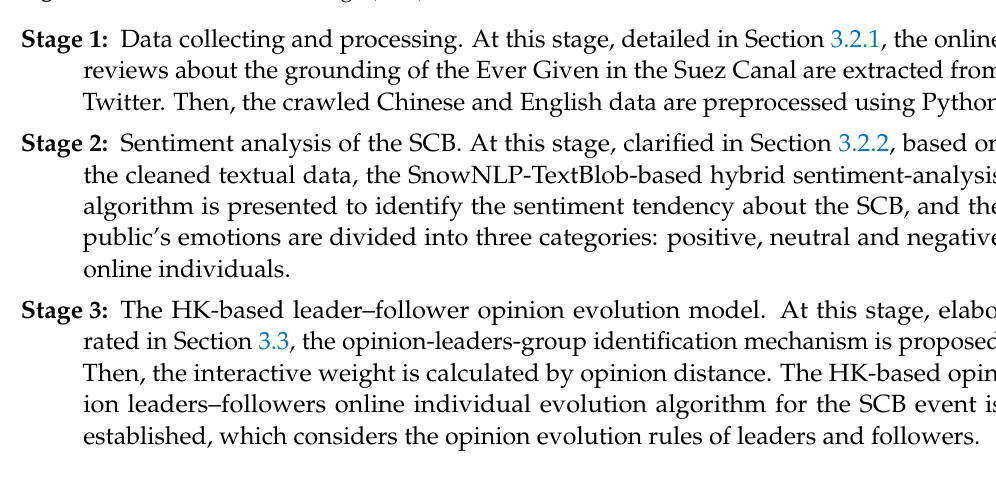
Figure 1. The Suez Canal blockage (SCB)